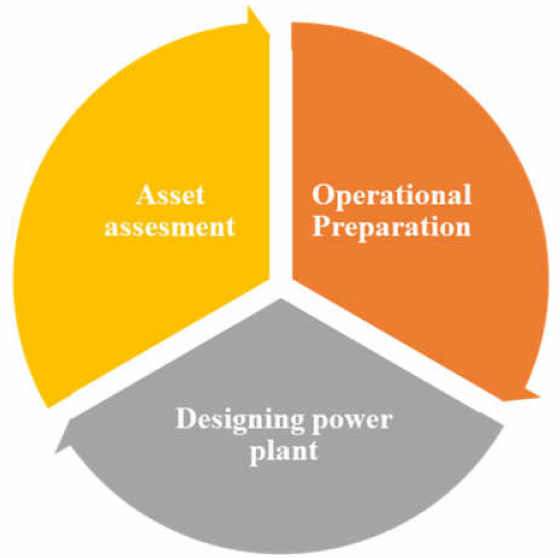
Figure 2. Supply chain for Bioenergy.